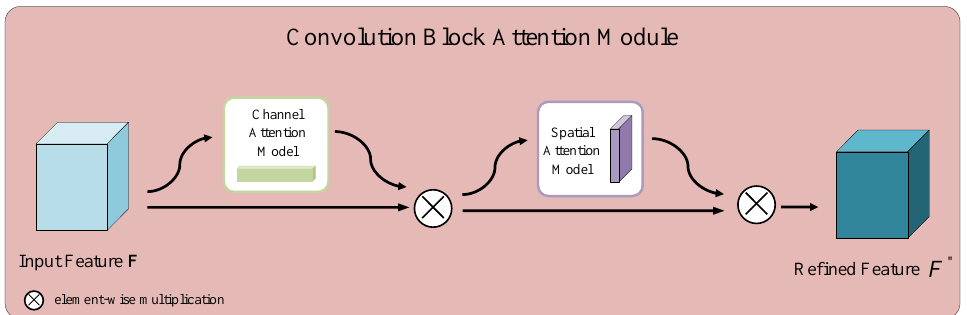
Figure 5. Convolutional block attention module.